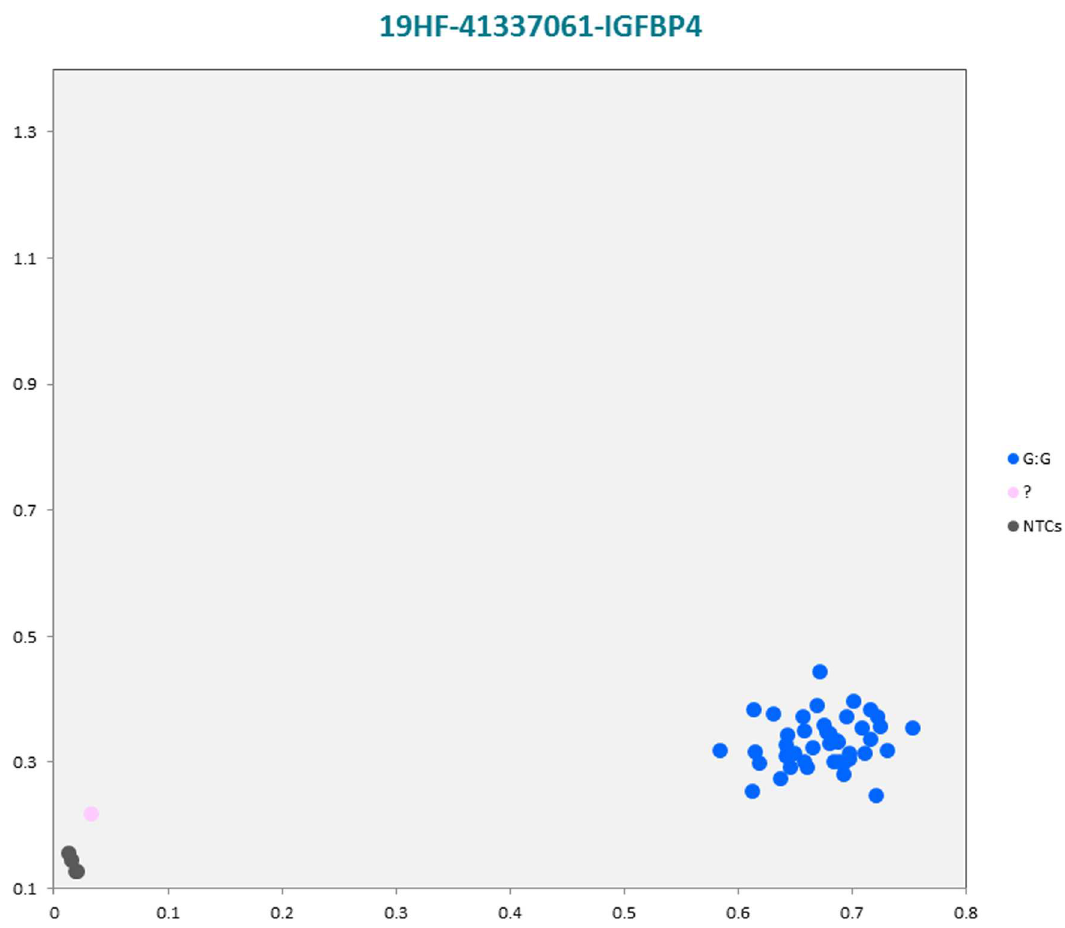
Fig 8. KASP TM SNP genotyping assay of BTA19_41337061locus of Polish HF IGFBP4 gene showing the data for single KASP TM assayson a single cluster plot.